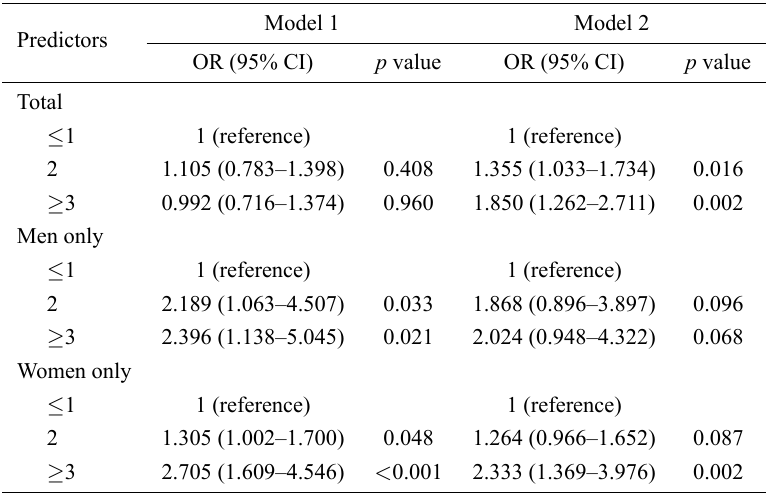
Table 4. Odds ratios (ORs) and 95% confidence intervals (CIs) of depression according to number of lifestyle risk